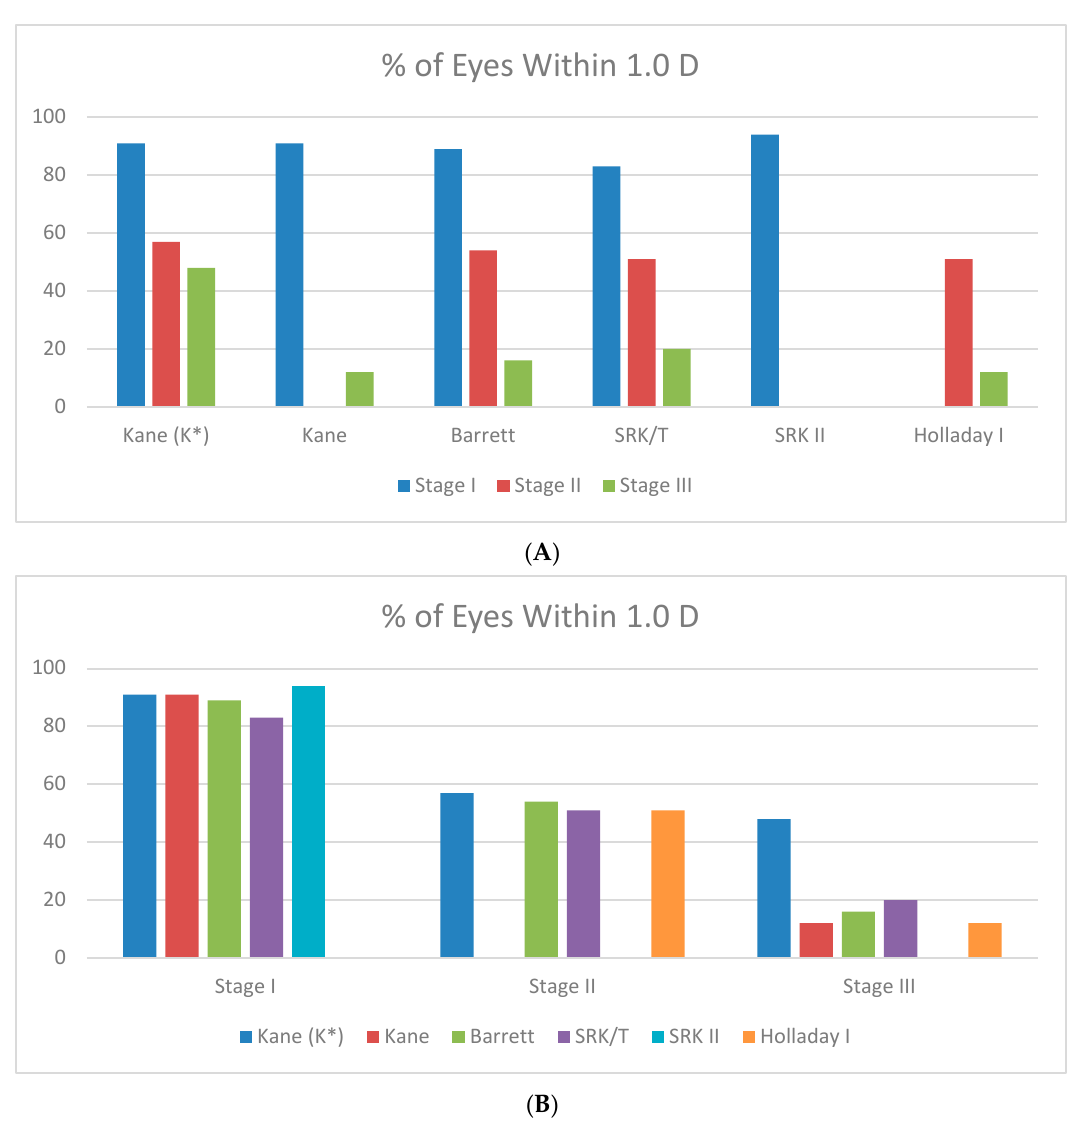
Figure 1. ( A ) Percentage of eyes within 1.0D in accordance to IOL formula; ( B ) Percentage of eyes within 1.0D in accordance to the Keratoconus stage.